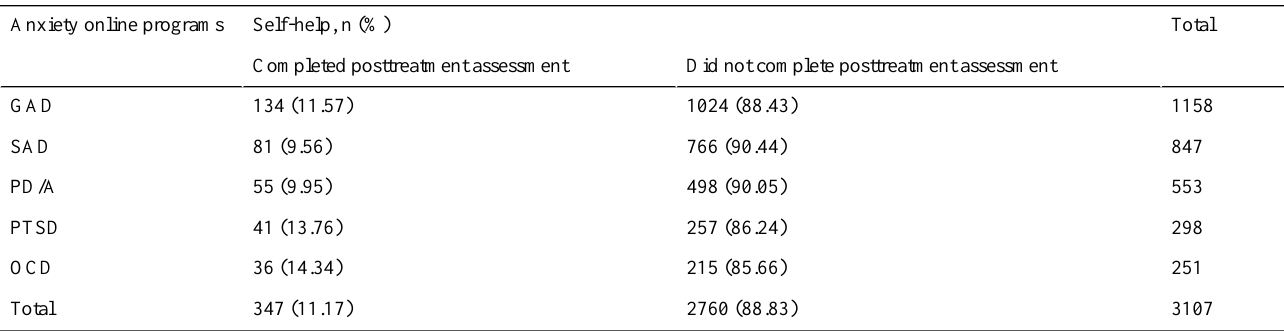
Table 1. Number of individuals enrolled in the self-help online programs that completed or did not complete the posttreatment assessment measures. TotalSelf-help, n (%)Anxiety online programs